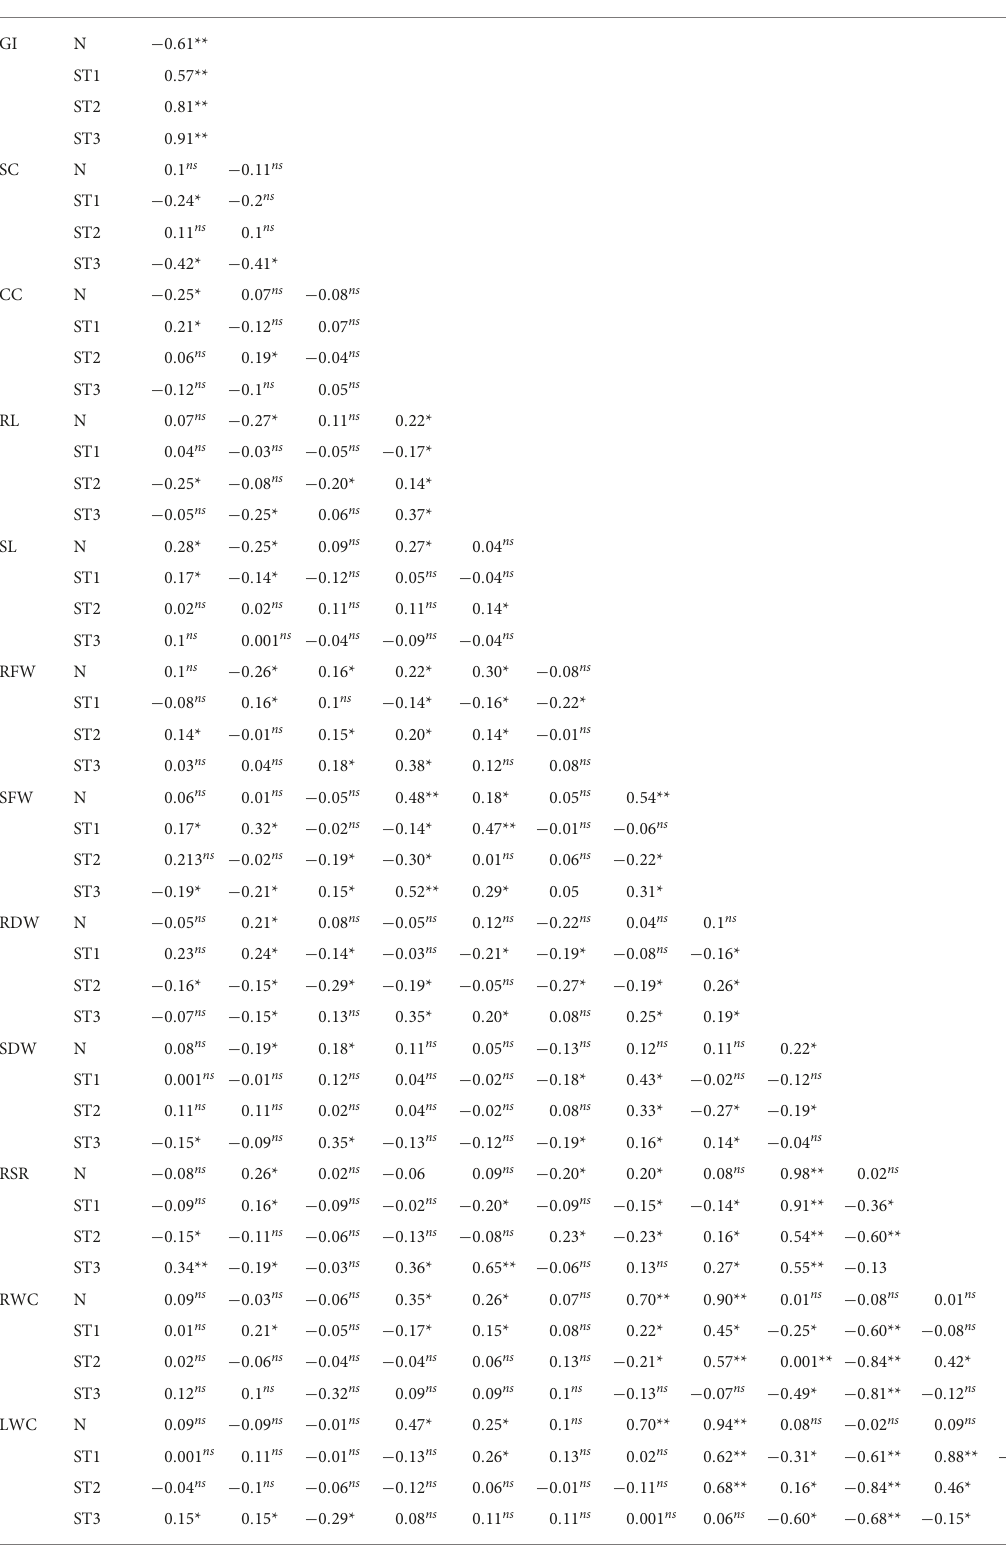
TABLE 3 Correlation matrix among wheat seedling traits under normal and stress environment.